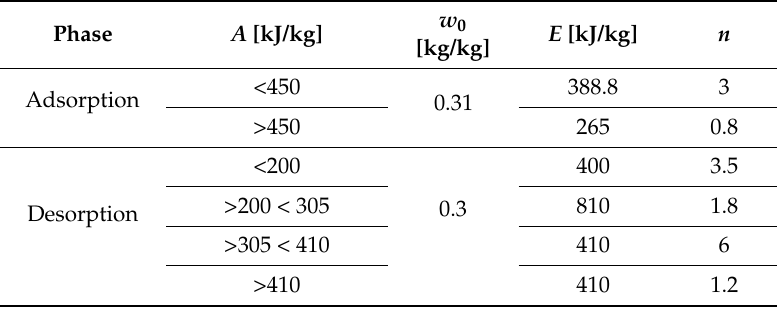
Table A1. Parameters of equilibrium equation [11].